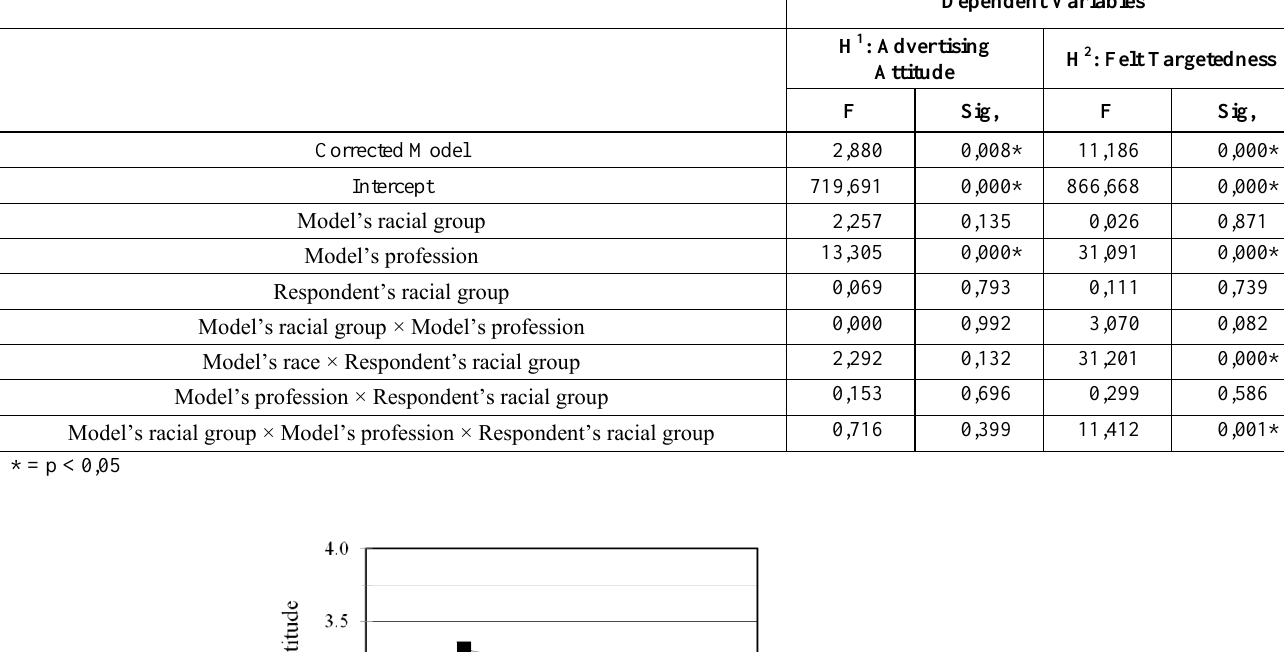
Table 1: Hypotheses H 1 and H 2 – Three-way ANOVA